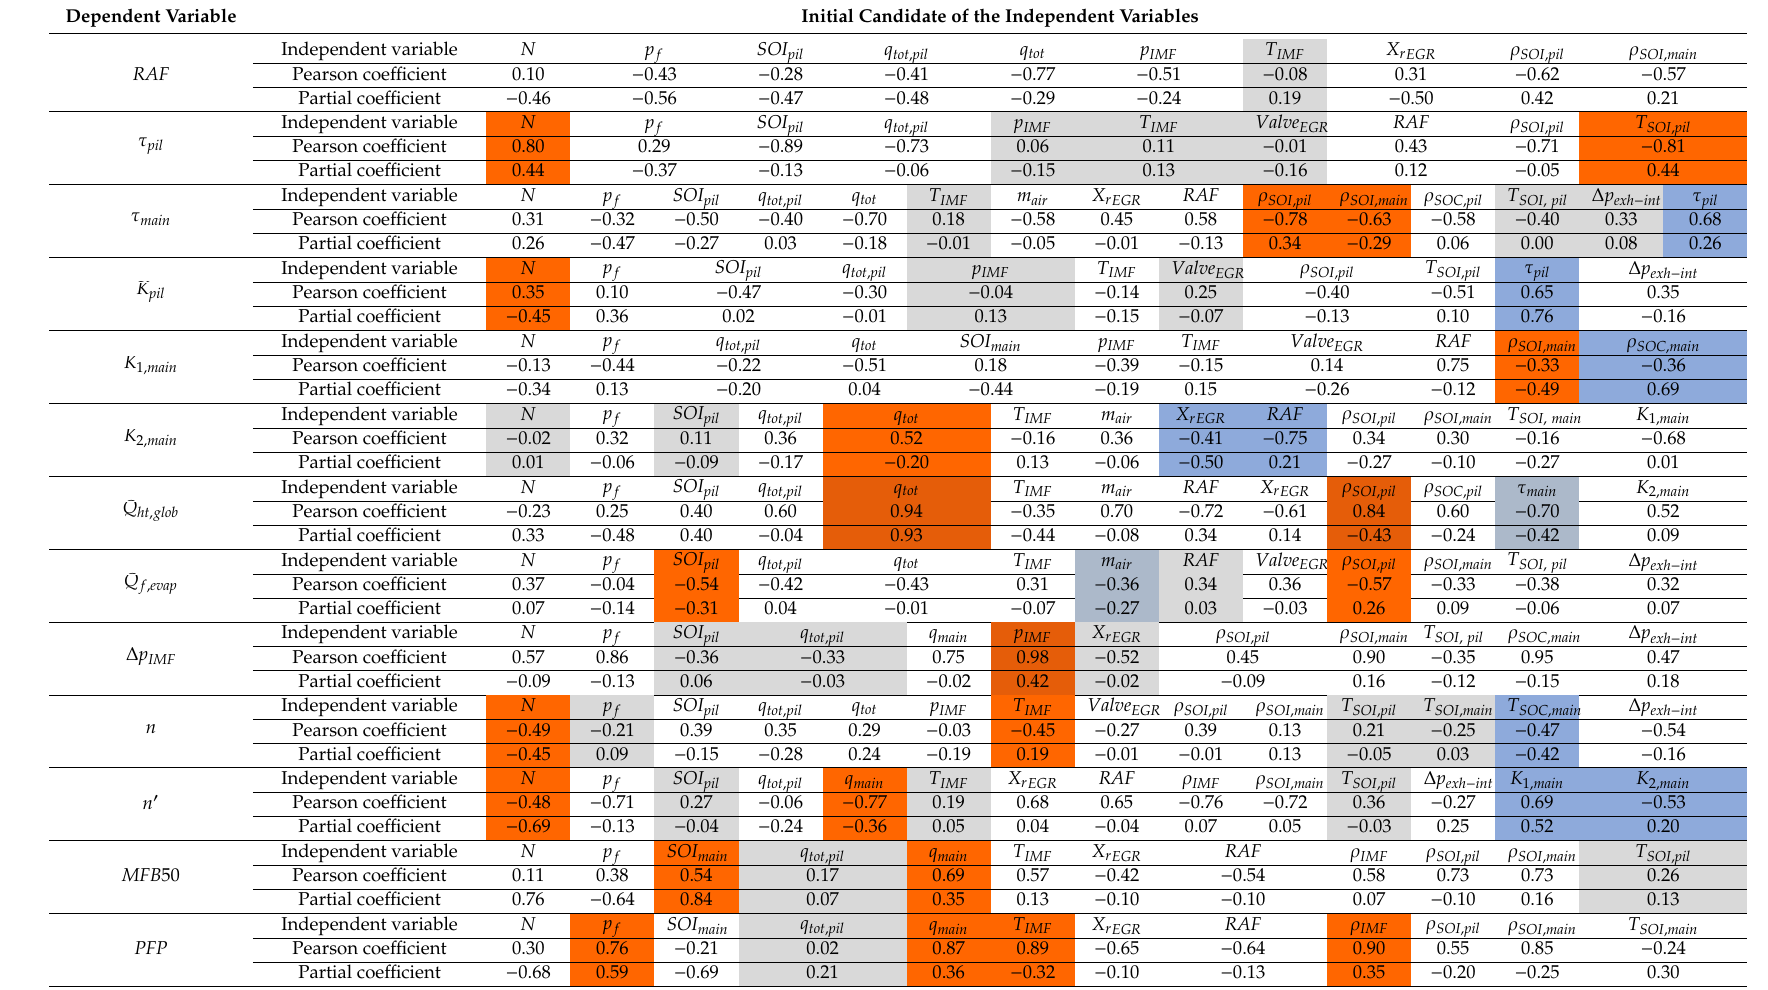
Table A3. Pearson and partial correlation coe ffi cients for the input variables of the initial candidate